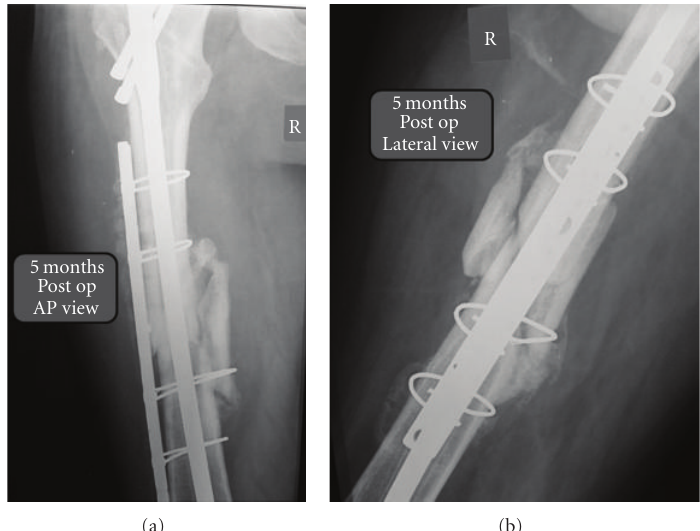
Figure 6: Radiographic imaging of femoral reconstruction five months postoperatively in (a) anteroposterior and (b) lateral view, showing progression of callus